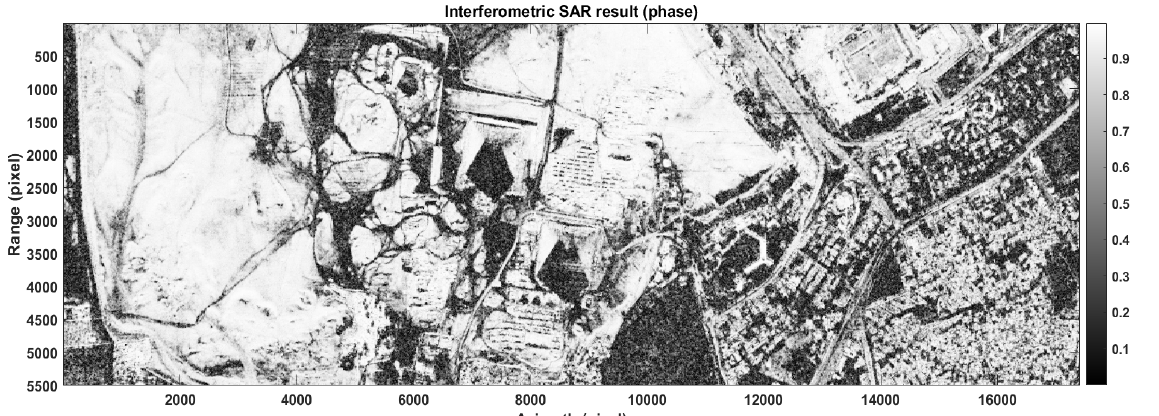
Figure 10. SAR image representing the interferometric repeat-pass phase of the Giza plateau.